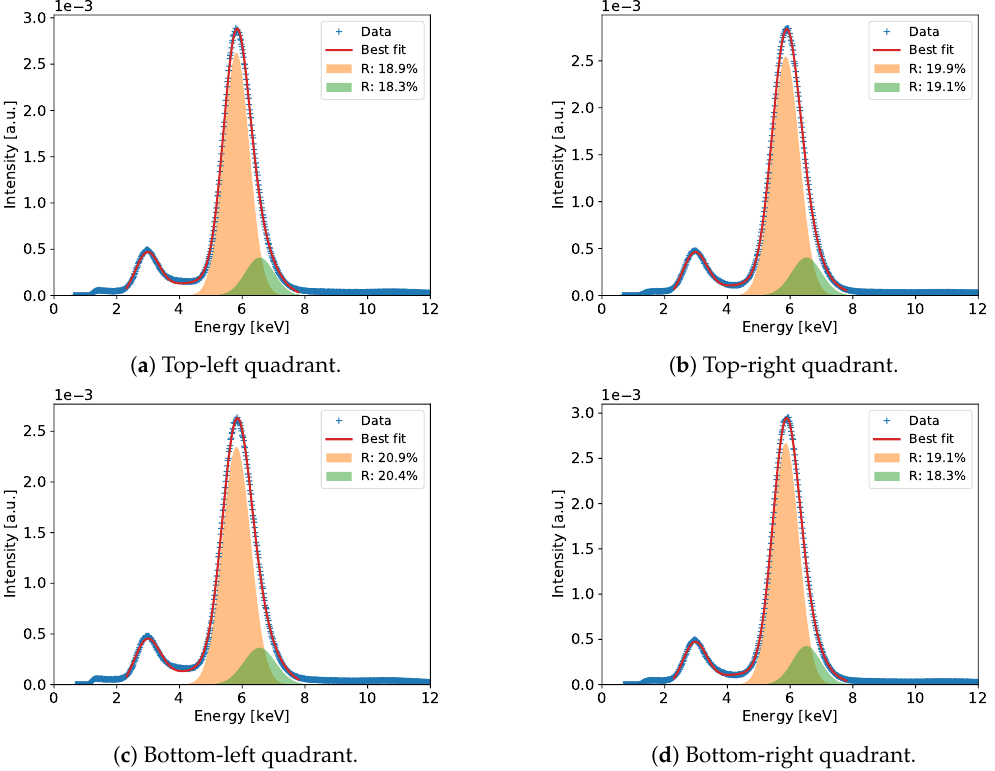
Figure 18. GEM detector D . 55 Fe spectrum for detector bias voltage of 3770V for each quadrant of the detector.